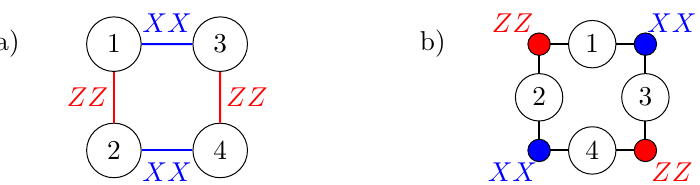
Figure 5. Two views of the 2 × 2 Bacon-Shor code (a) qubits at vertices with gauge generator on edges or (b) qubits as edges with gauge generators at